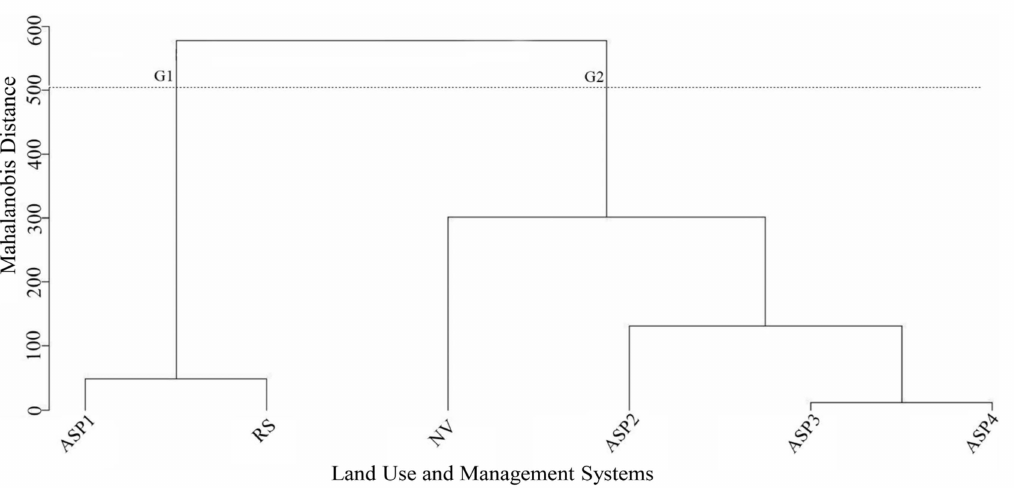
Figure 4. Dendrogram from hierarchical clusters analysis showing the formation groups for land use and management systems according to the soil attributes at 0–30 cm soil depth layer. G1: Group 1; and G2: Group 2. Systems: E. camaldulensis × E. tereticornis hybrid intercropped with buffel grass using the arrangements 2 × 3 + 10 m (ASP1) and 2 × 3 + 15 m (ASP2); E. urophylla × E. grandis hybrid intercropped with buffel grass using the arrangements 2 × 3 + 10 m (ASP3) and 2 × 3 + 15 m